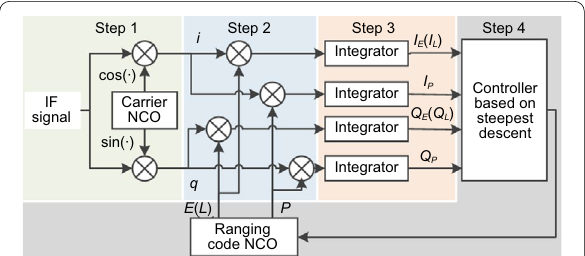
Fig. 3 Proposed ranging code tracking loop. If the iteration process of τ adopts the left partial derivative of the cost function, this method needs the late branch L and the punctual branch P . If the iteration process of τ employs the right partial derivative of the cost function, this method utilizes the early branch E and the punctual branch P . IF is the abbreviation of intermediate frequency. NCO is